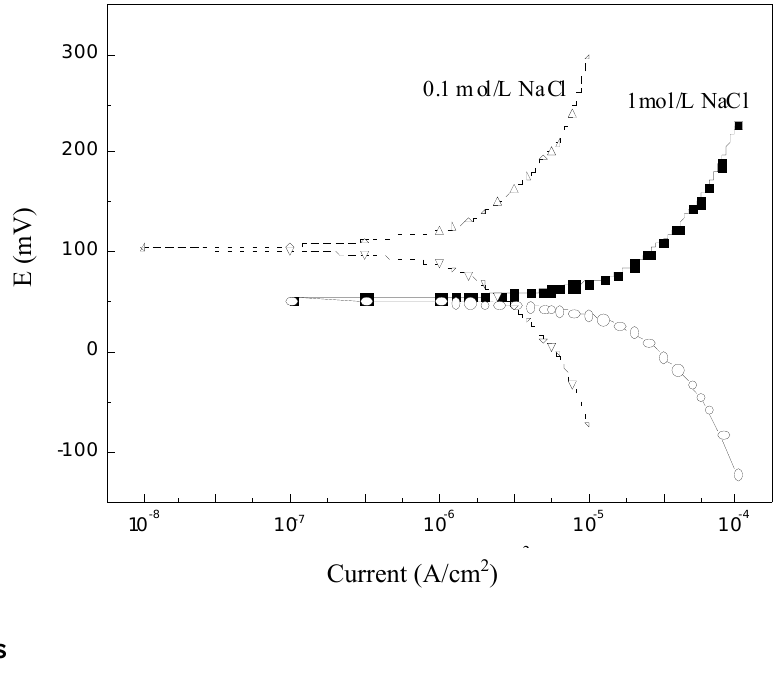
Figure 6. Potentiodynamic polarization curves of sensor in synthetic concrete pore solutions with